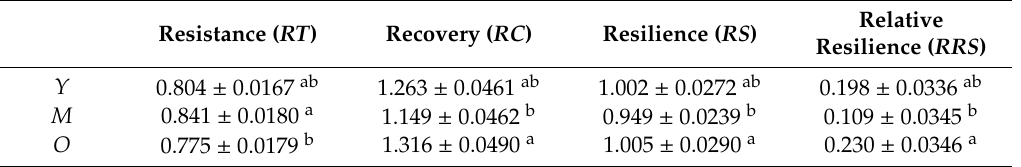
Figure 7. Scatter plots of the resistance indexes ( RT , RC , RS , and RRS ) of the Schrenk spruce trees of three age groups in seven drought years. The black triangles indicate the average of values obtained in seven different years. RT : resistance; RC : recovery; RS : resilience; RRS : relative resilience; Y: young group; M: middle-aged group; O: old group. Table 3. Discrepancy analysis of the resistance indexes of Schrenk spruce trees in three di ff erent age groups by one-way analysis of variance ( ANOVA